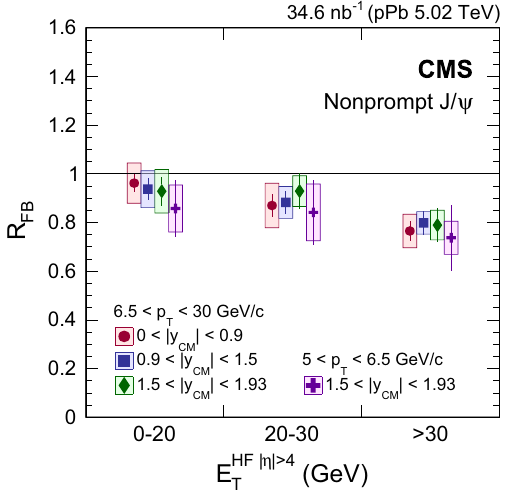
Fig. 13 Dependence of R FB for nonprompt J /ψ mesons on the hadronic activity in the event, given by the transverse energy deposited in the CMS detector at large pseudorapidities E HF slightly shifted horizontally so that they do not overlap. The vertical bars represent the statistical uncertainties and the shaded boxes show the systematic